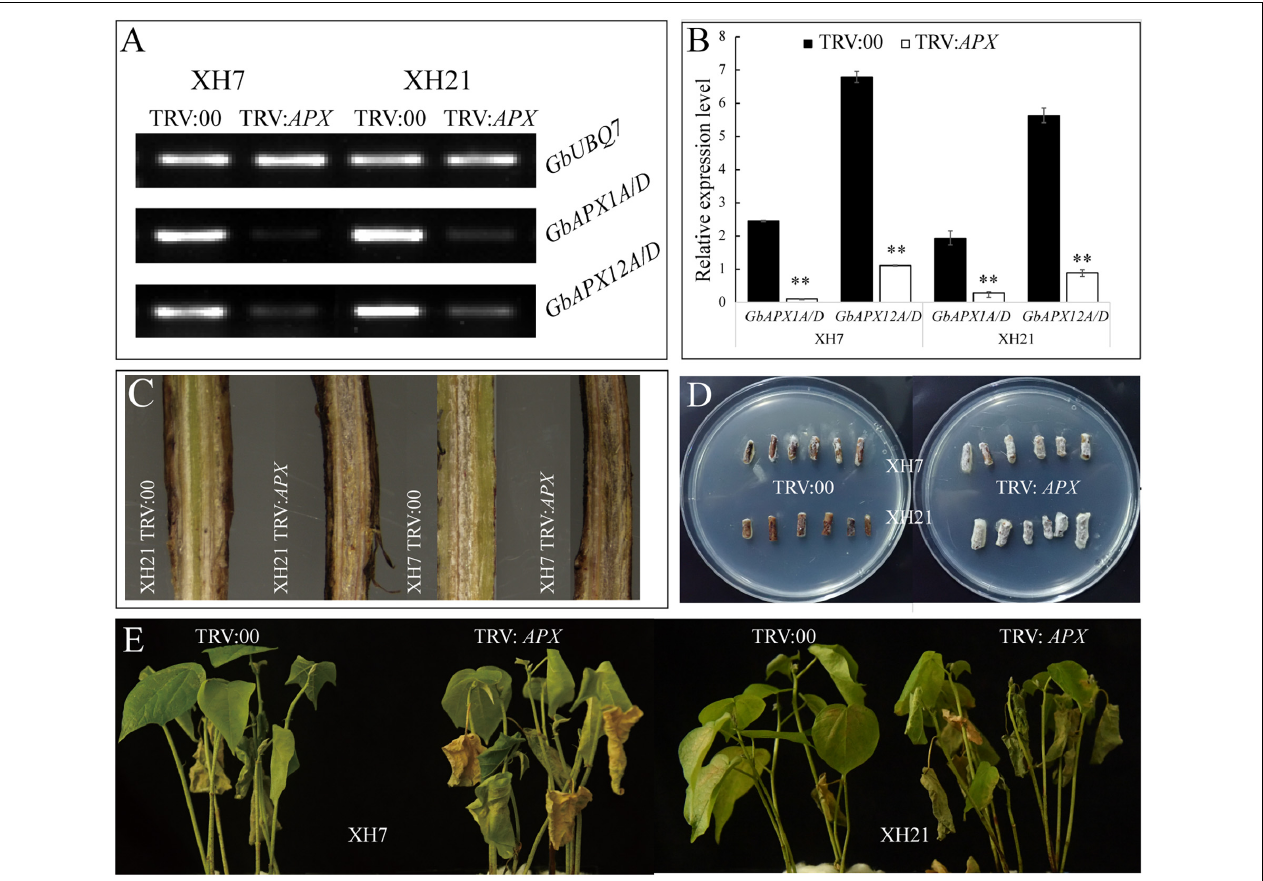
FIGURE 5 | The resistance of VIGS plants to V. dahlia was compromised. Semi-quantitative (A) and real-time quantitative (B) PCR were used to select successfully silenced transformants. Three replicates were performed for each transformed plant. ∗∗ p < 0.01. (C) Fungal accumulation in the stems of TRV: 00 and TRV: GbAPX1/12 plants. (D) Fungal hyphae recovery assays of the V. dahlia -infected cotton. The stem sections were plated on PDA medium, incubated at 25 ◦ C, and photographed at 5 days post-plating. (E) Disease symptoms for the representative plants of TRV:00 and TRV: GbAPX1/12 at 14 days after inoculation. N = 18 for each